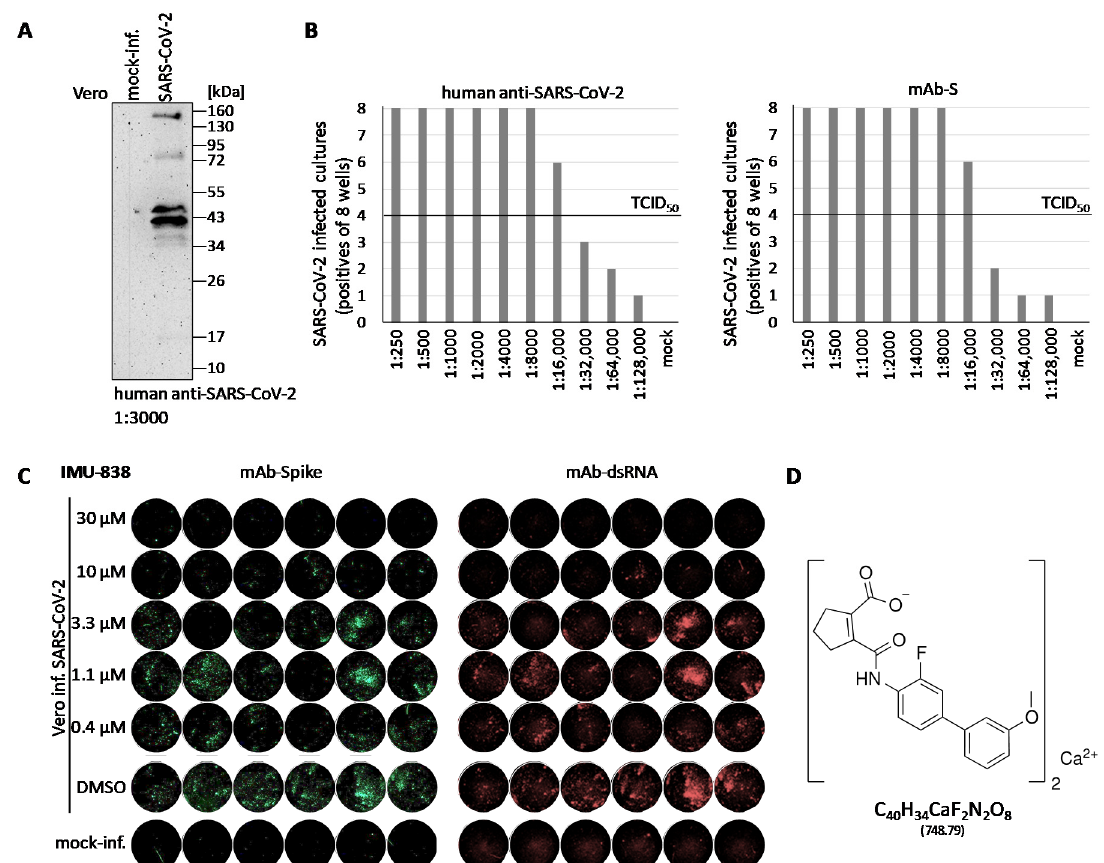
Figure 1. Use of a clinical isolate of severe acute respiratory syndrome coronavirus type 2 (SARS-CoV-2) for cell-culture-based infection assays. ( A ) Demonstration of productive viral replication. Vero cells were seeded in T25 flasks (2.5 × 10 6 cells), used for infection with SARS-CoV-2 at a multiplicity of infection (MOI) of approx. 1 and harvested at 2 days post-infection (p.i.). Total lysates were subjected to standard SDS-PAGE / Western blot analysis and immunostained using a human convalescent antiserum at a dilution of 1:3000. ( B ) Titration of infectious viral stocks. SARS-CoV-2 infection was performed on Vero cells cultured in a 96-well plate applying serial dilutions as indicated. Cells were harvested at 2 days p.i. and virus-specific immunostaining was performed by in-cell ELISA using human anti-SARS-CoV-2 or by in-cell IF staining using an monoclonal antibody against the viral spike protein (mAb-S), as indicated, to determine numbers of infected cultures for subsequent calculation of tissue culture infectious doses (TCID 50 / mL). ( C ) In-cell IF assay, using mAb-S (left panel) and mAb-dsRNA (right panel), showing the concentration-dependent IMU-838-mediated inhibition of viral spike protein or RNA production, respectively. Vero cells were seeded in 96-well plates one day before infection (3 × 10 4 cells / well) with SARS-CoV-2 at an MOI of 0.003 and treated with the concentrations of 30, 10, 3.3, 1.1 and 0.4 µM of IMU-838. At 30 h p.i., cells were fixed and used for the IF antibody staining. DMSO, viral replication control with solvent only; mock-inf., uninfected cells used as a background negative control. ( D ) Structure of IMU-838, which is the calcium salt of vidofludimus.